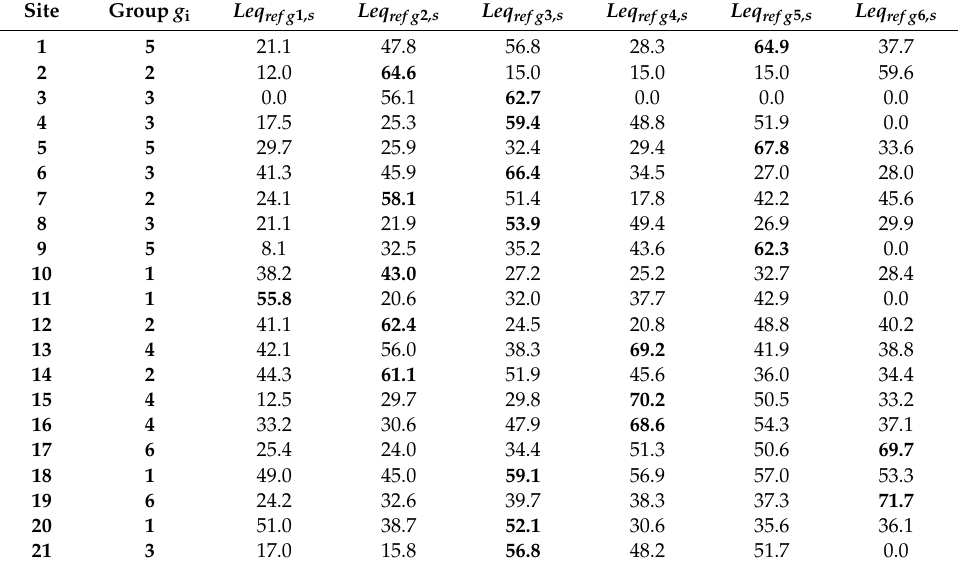
Table 6. Level contributions of each group, Leq refg, s at 21 arbitrary chosen sites of District 9 (Figure 9). The group indices of each sites are shown in the second column. Bold figures represent the major contribution to the local site